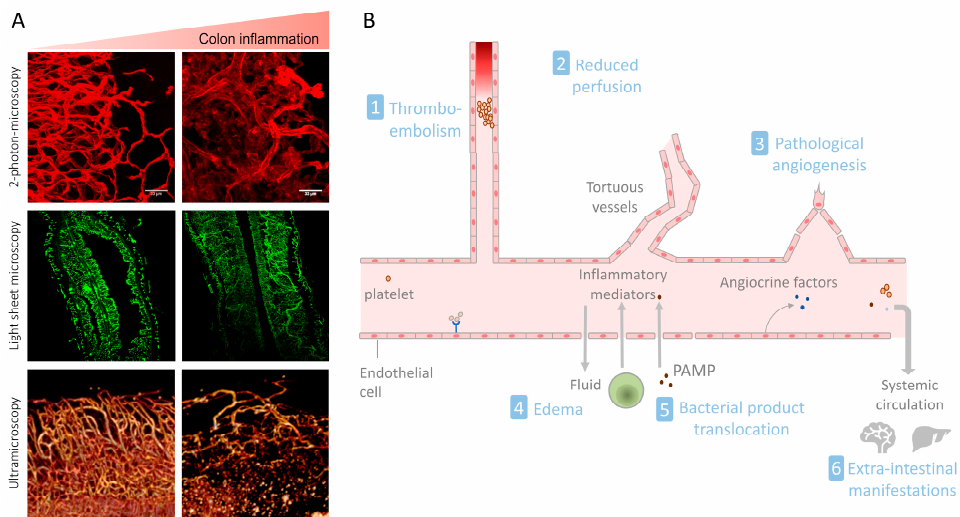
flammation. The vessel structure was analyzed in mouse colon samples in the absence (left) or presence (right) of colitis. Vessels were visualized via the staining of CD31 (2-photon microscopy) or via lectin-staining (light sheet microscopy and ultramicroscopy). ( B ). Vascular changes and dysfunction observed in IBD participate in the initiation and perpetuation of mucosal inflammation and extra- cellular manifestations. PAMP: pathogen-associated molecular pattern.